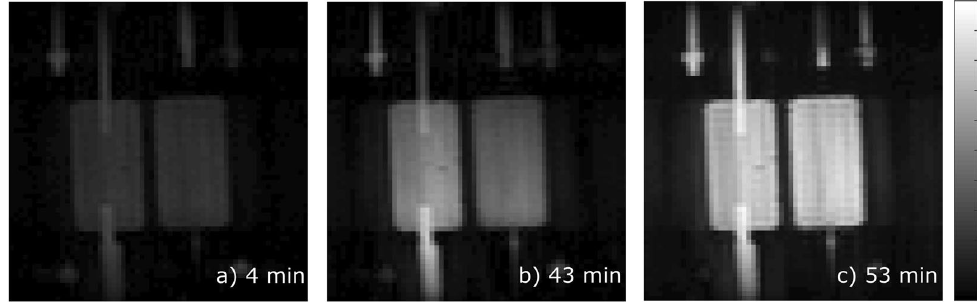
Figure 3. ( a ) The image was recorded 4 min after the start of the experiment, meaning that the bolus with contrast agent was currently injected into the circulation system. ( b ) 43 min after bolus injection the left compartment already shows a homogenous distribution of the contrast agent. ( c ) A homogenous distribution of the contrast agent in both compartments is reached 53 min after bolus injection.